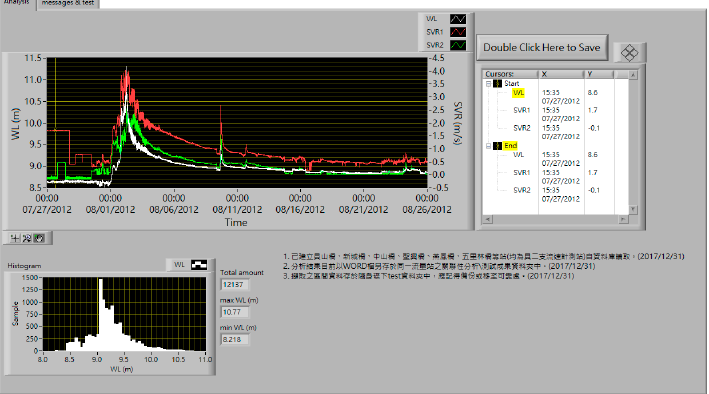
Figure 4. Data sampling using human–machine interface software.